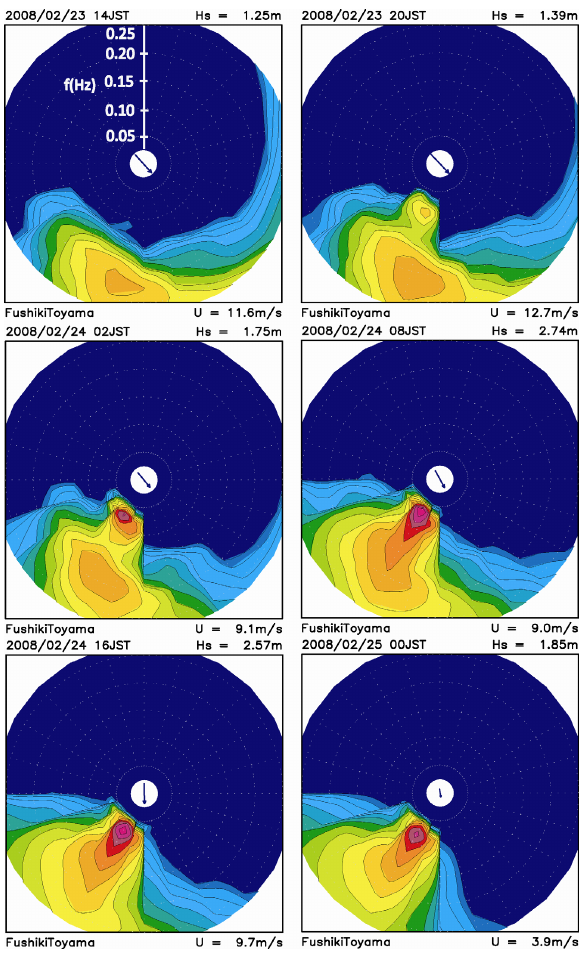
Fig. 17. Calculated 2-D wave spectral plots at Fushiki Toyama, Japan, for the event of February 2008. Time and significant wave height are shown above each panel, while wind speed and direction are shown below and in the centre of each panel, respectively. The 16-level shaded colours represent wave energy density (m 2 /Hz) being doubled in each level, with dark blue indicating the absence of wave energy (1.61238e-04) and light purple indicating a local maximum (10.56695). Wave direction is toward the edge of the plot.